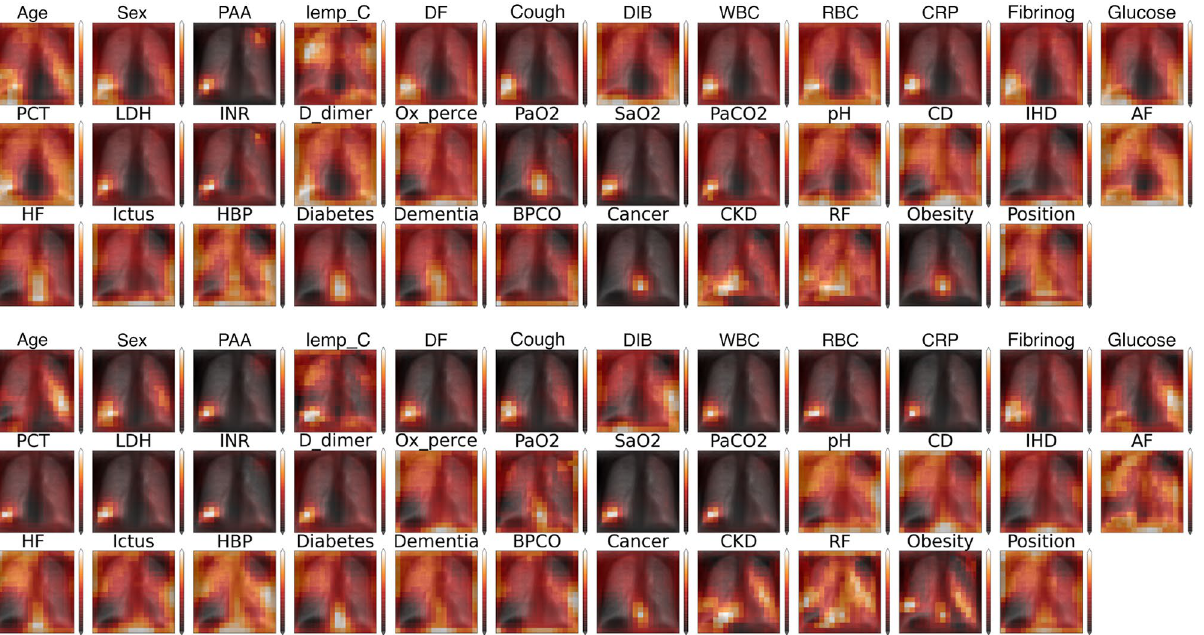
Figure 7. Individually scaled mean severe attention maps (top) and mean mild attention maps (bottom) on the test data. Here we can see high attention on the lower right lobe in both cases, with significant attention also on the heart and the region around it (HF—hearth failure, HBP—high blood pressure, CD—Patient had cardiovascular disease).